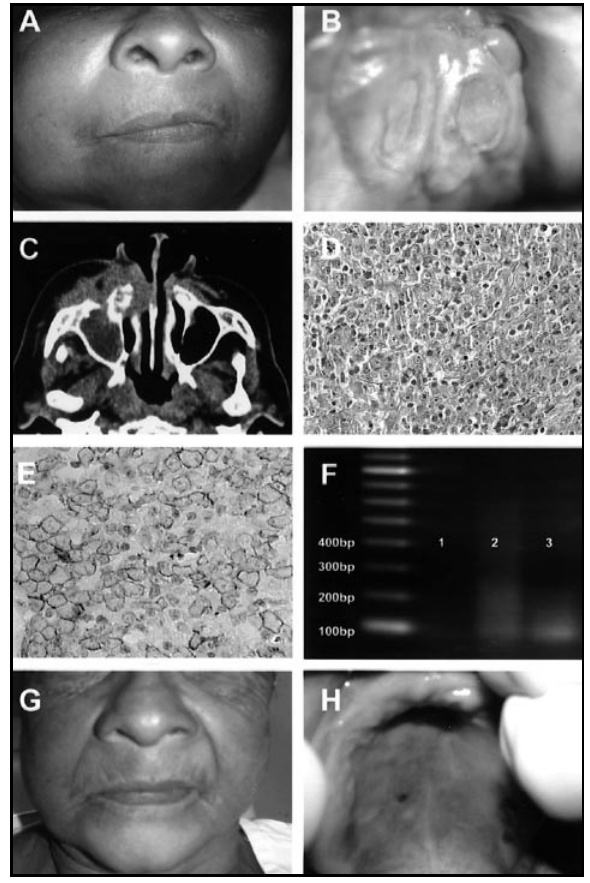
Figure 1 – A: Asymmetry and swelling of the right side of the face; B: tumoral swelling in the palate with two 3-cm eroded areas; C: computed tomography demonstrated invasion of maxillary sinus, nasal cavity and soft tissue of the right side; D: neoplastic cells are represented by centroblasts (large cell with two or more nucleolus) and immunoblasts (large with one nucleolus) (haematoxilin and eosin, original magnification 400x); E: immunoblasts and centroblasts are CD20-positive (streptoavidin-biotin technique; Dako Corporation, Carpinteria, CA, USA; clone L26; dilution 1:50, antigen retrieval with 0.01 M citric acid, 95 o C, 30 min); F: IgH analysis demonstrated a discrete and homogenous band of approximately 80 bp on electrophoresis (line 3) (polymerase chain reaction technique, bp: base pairs; line 1: negative control, line 2: polyclonal pattern-tonsil; line 3: current case-monoclonal pattern); G and H: patients following three cycles of chemotherapy. Clinical improvement was